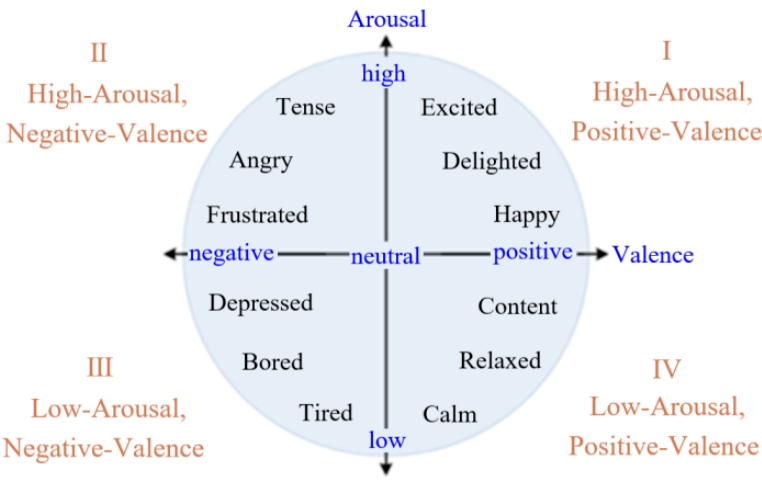
Figure 1. Valence–arousal model.